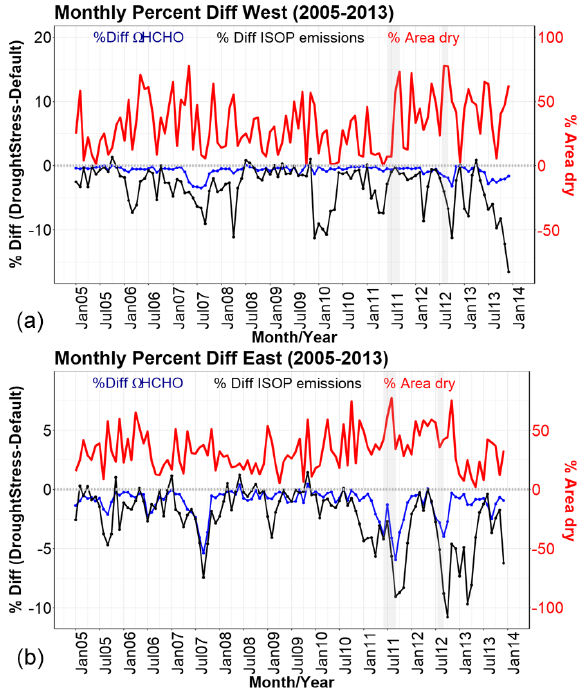
Figure 5. The percent difference of (cid:127) HCHO and isoprene emis- sions from 2005–2013 in relationship to percent area dry for two regions of the US: West (a) and East (b) . Percent dry area is indi- cated by SPEI < − 0 . 5. The first grey shaded rectangle indicates the time period of the 2011 drought at MOFLUX from June to August 2011. The second grey shaded rectangle indicates the 2012 severe drought at MOFLUX from 17 July through August. These time pe- riods are added to the time series to highlight when they